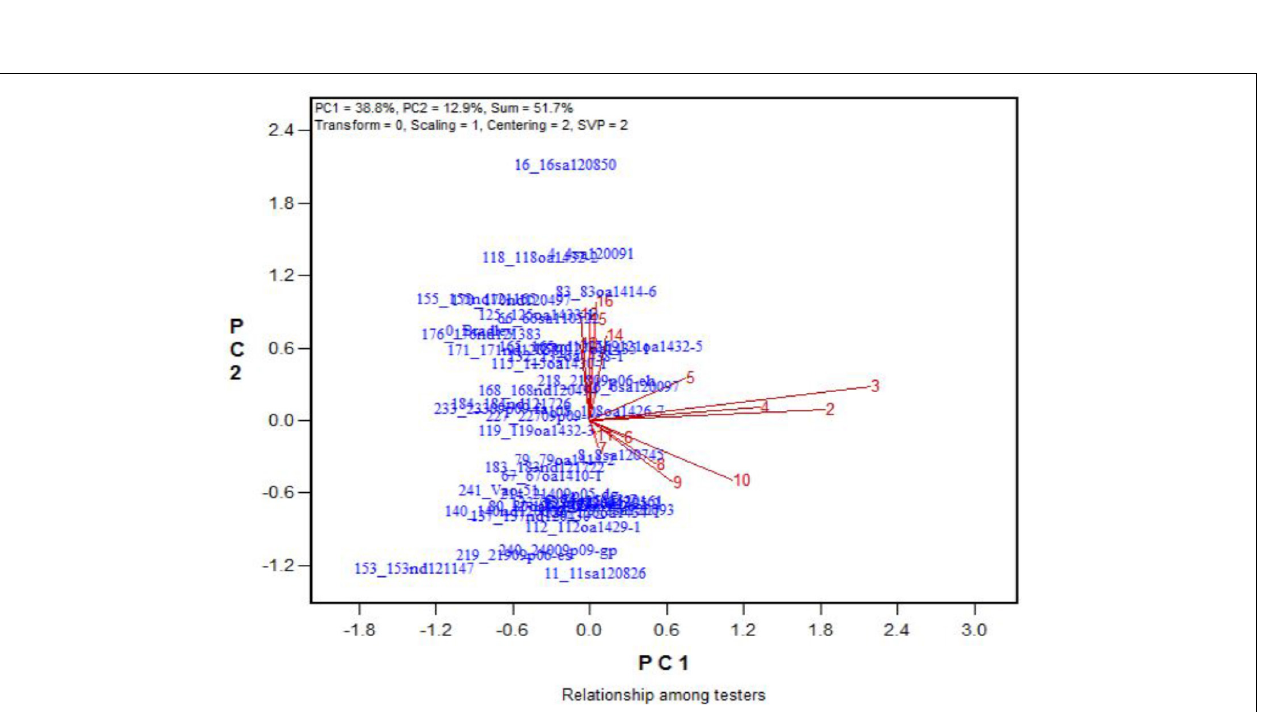
Frontiers in Plant Science |